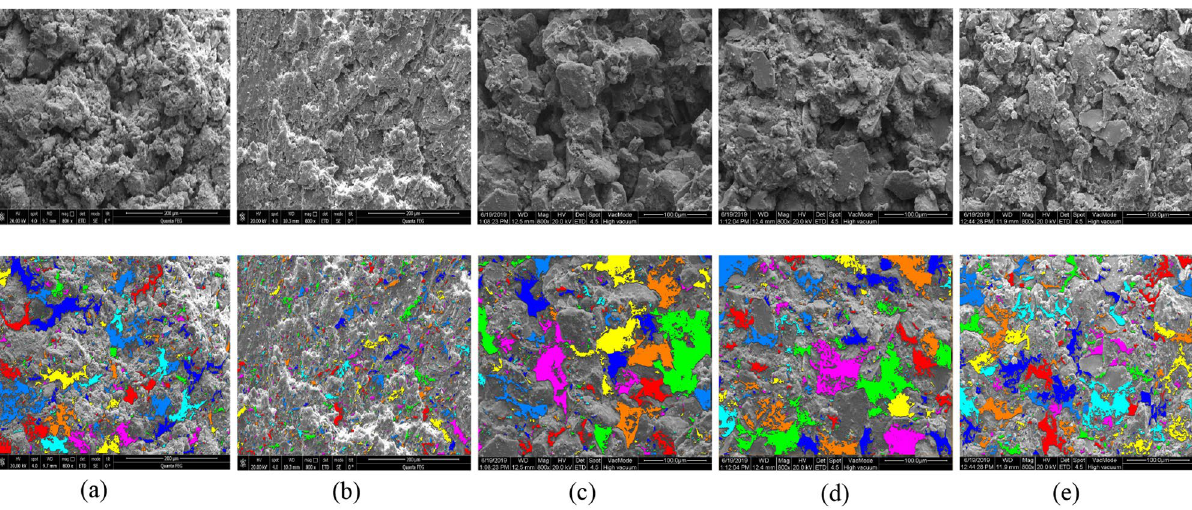
Figure 13. SEM images of shear surface with different moisture contents (800 × , σ n = 200 kPa, v = 1 mm/min). ( a ) Loess, Mc = 12%; ( b ) red clay, Mc = 12%; ( c ) LRCI, Mc = 12%; ( d ) LRCI, Mc = 20%; ( e ) LRCI, Mc =